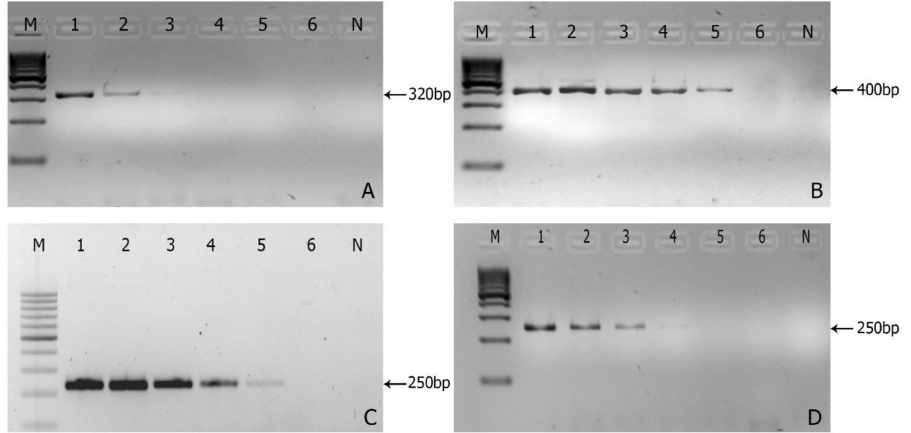
Figure 3. Sensitivity of the primer sets FocR1F/FocR1R ( A ), FocR4F/FocR4R ( B ), Foc TR4F /Foc TR4R ( C ), and Foc STR4F /Foc STR4R ( D ). A serial dilution of genomic DNA ranging from 200 ng to 0.02 pg µ L − 1 was used; where 1: 200 ng; 2: 100 ng; 3: 10 ng; 4: 1 ng; 5: 10 pg; and 6: 1 pg. Lanes M—100 bp Marker; N—Negative control.